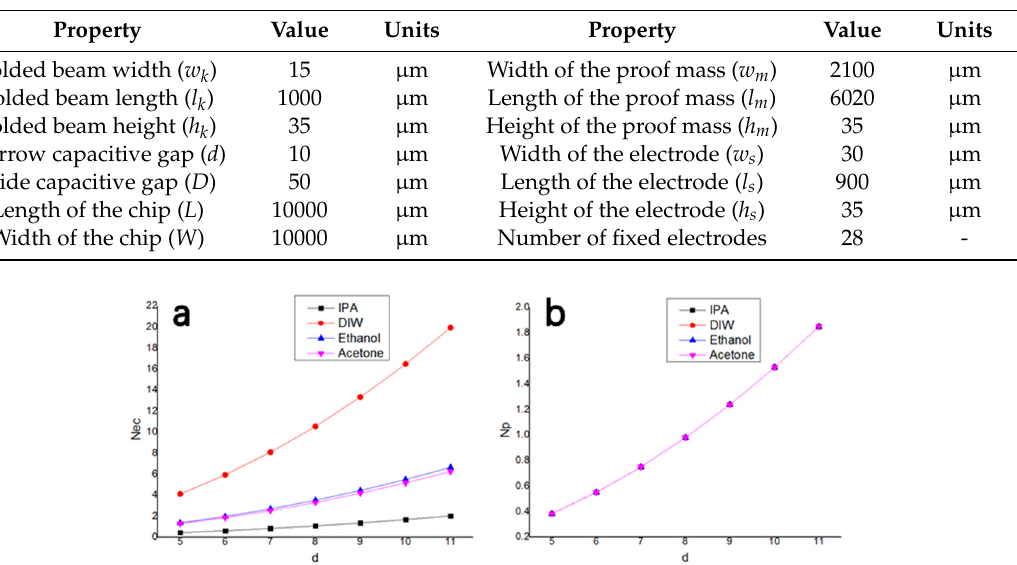
Figure 10. Trend diagrams of the dimensionless parameters N EC and N P with a small spacing d : ( a ) Trend diagram of N EC for four di ff erent solutions with d ; ( b ) trend diagram of N P for four di ff erent solutions with d .